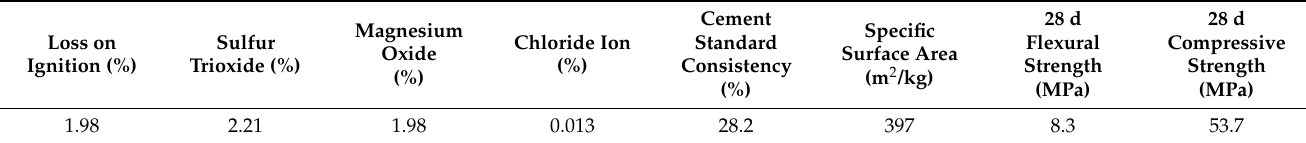
Table 1. Basic parameters of cement.